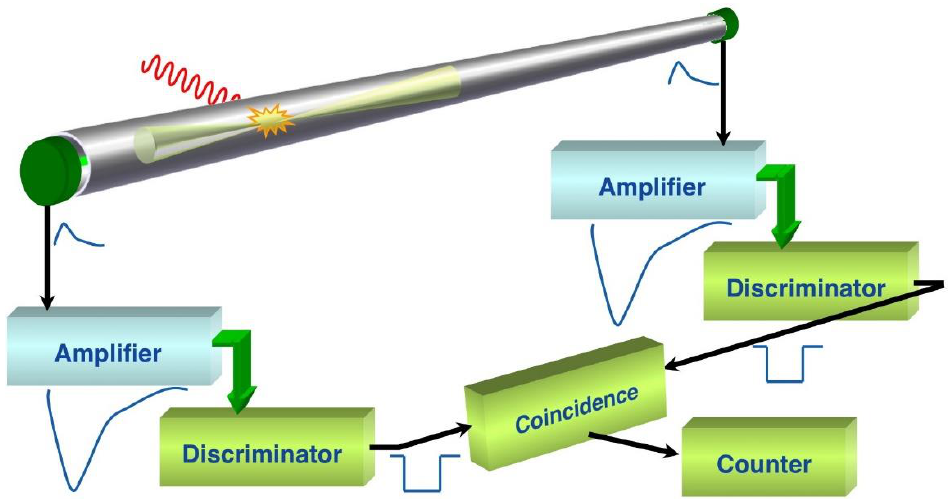
Figure 10. Sketch of the electronic setup for the SciFi